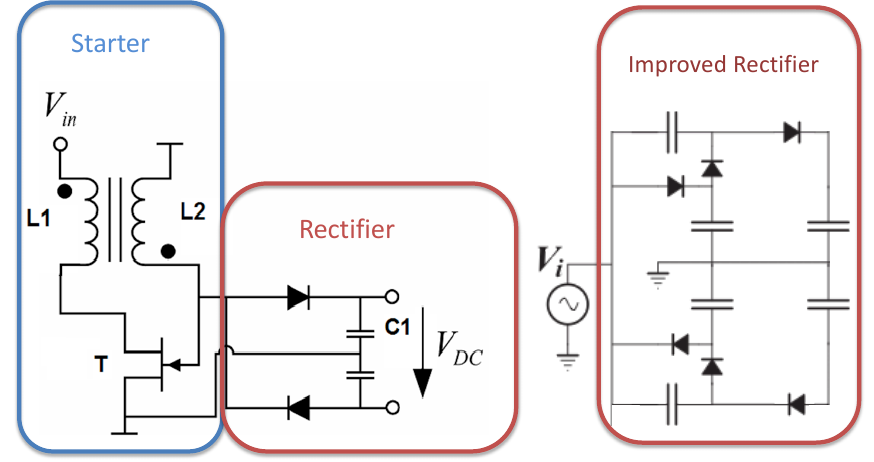
Figure 9. The hybrid converter presented in [31].